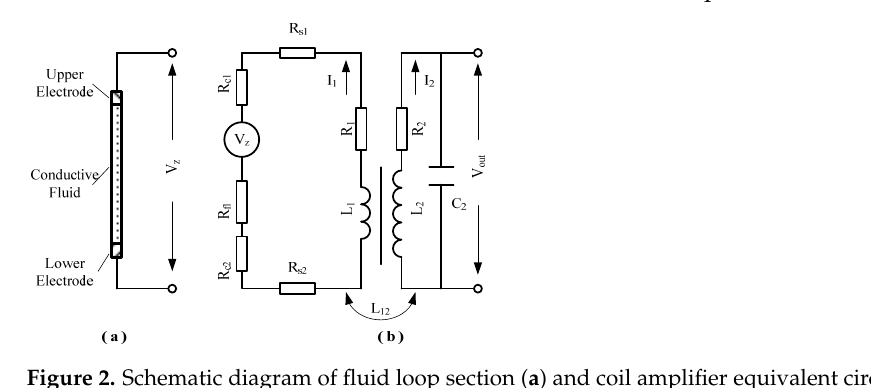
Figure 2. Schematic diagram of fluid loop section ( a ) and coil amplifier equivalent circuit ( b